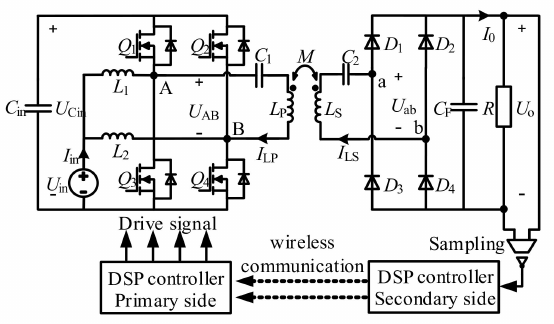
Figure 1. Schematic diagram of WPT system based on interleaved Boost converter.